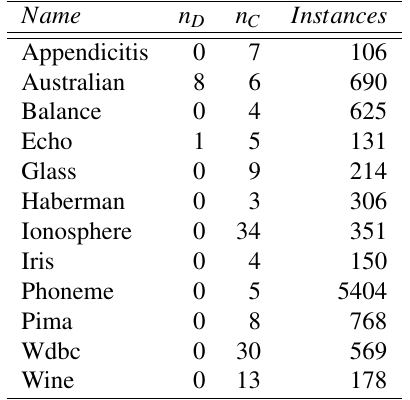
Table 1. Data sets employed in the experimental